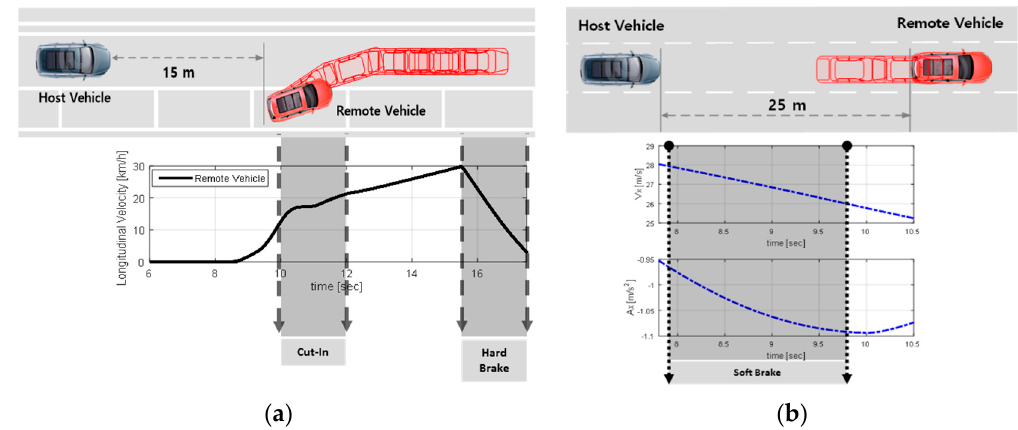
Figure 6. Simulation Scenarios: ( a ) Parked Remote Vehicle Cut-in and Braking; ( b ) Remote Vehicle Braking on the Highway.